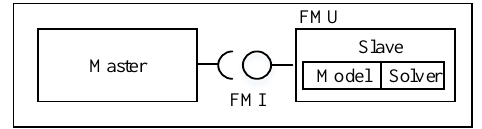
Figure 16. FMI CS mode simulation mechanism.